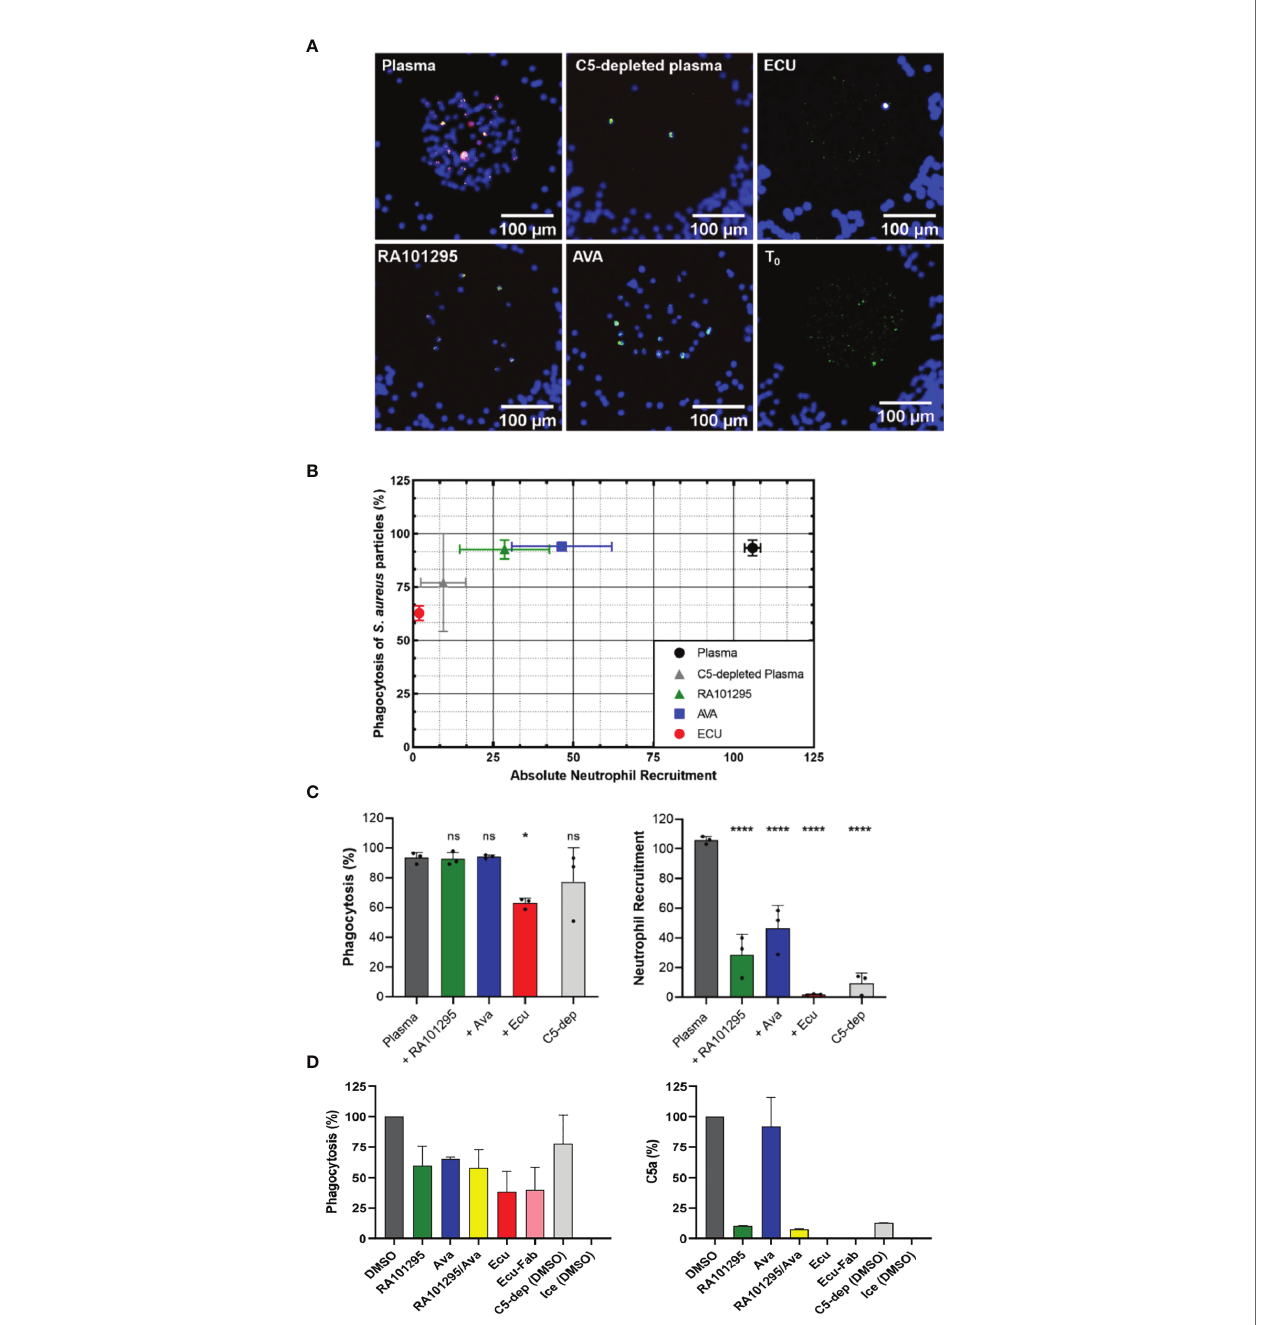
FIGURE 6 | Effect of complement inhibitors on neutrophil phagocytosis behavior of S. aureus -particles. (A) Microscopic fl uorescent images of the central reservoir of the device at the end of an experiment, showing neutrophils nuclei labeled in blue (Hoechst 33342), S. aureus particles labeled in green (FITC), and phagosome acidi fi cation in red (pHrodo) once phagocytosed by neutrophils. T 0 shows the initial number of S. aureus particles present in the central reservoir before chemotaxis and phagocytosis events. (B) End-point results of phagocytosis percentage vs. recruitment of neutrophils in plasma pretreated with ECU, RA101295, and AVA pretreated neutrophils. (C) Effect of C5 inhibition with ECU (3 µM), AVA (250 nM), and RA101295 (3 µM) on percentages of S. aureus particles phagocytosis and neutrophil recruitment numbers (N=3) (*p < 0.05; ****p < 0.0001; One-way ANOVA with Dunnett ’ s test). Only ECU-treated plasma affects phagocytosis of neutrophils signi fi cantly when compared to untreated plasma. Plasma pretreated with all three inhibitors decreases neutrophil recruitment signi fi cantly. (D) Neutrophil phagocytosis using fl ow cytometry for internalized particles. RA101295 (3 µM) reduced particle phagocytosis less than AVA and ECU. C5a concentration in sera shows that RA101295 exhibits residual C5 cleavage (C5a generation), unlike ECU or ECU-Fab. The combination of RA101295 and AVA did not further inhibit phagocytosis as compared to either agent alone (N=2). ns represents not statistical signi fi